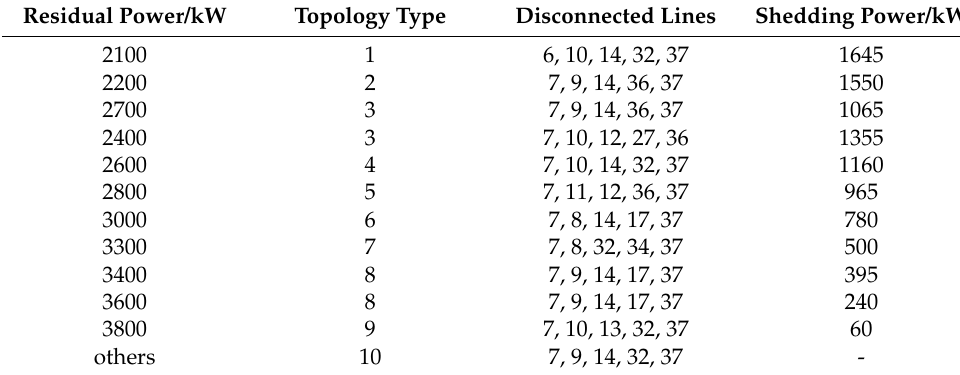
Table 1. Topology analysis of reconfiguration ‐ load shedding method.